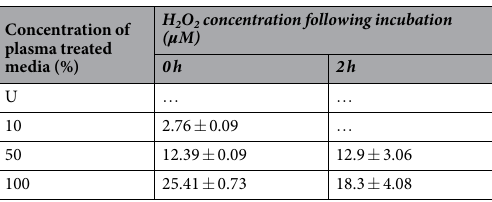
Table 1. Concentration of H 2 O 2 in untreated (U) RPMI 1640 and Ar plasma jet-treated RPMI 1640 (at concentrations of 10, 50 and 100%). Measurements were taken immediately following Ar plasma jet treatment (0 h) and following 2 h incubation (time-point of application to cells). The data presented is the mean value and ± standard error of the mean (SEM) of samples analyzed in triplicate ( n = 3). One-way ANOVA was used to determine the statistical significance of the values. All values are statistically significantly different ( P < 0.05). … Indicates concentration below detection